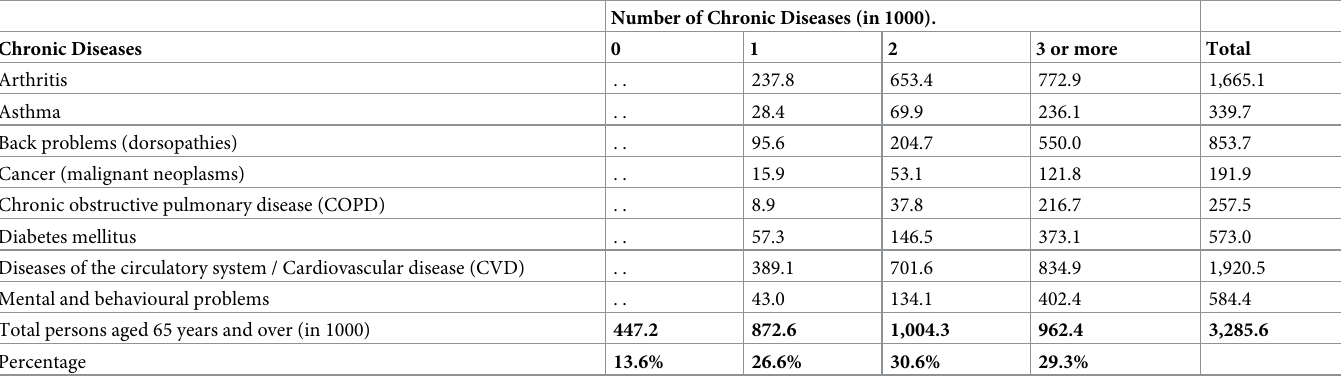
Table 3. Number of chronic diseases of Australian population aged 65 years and over (in 1000).